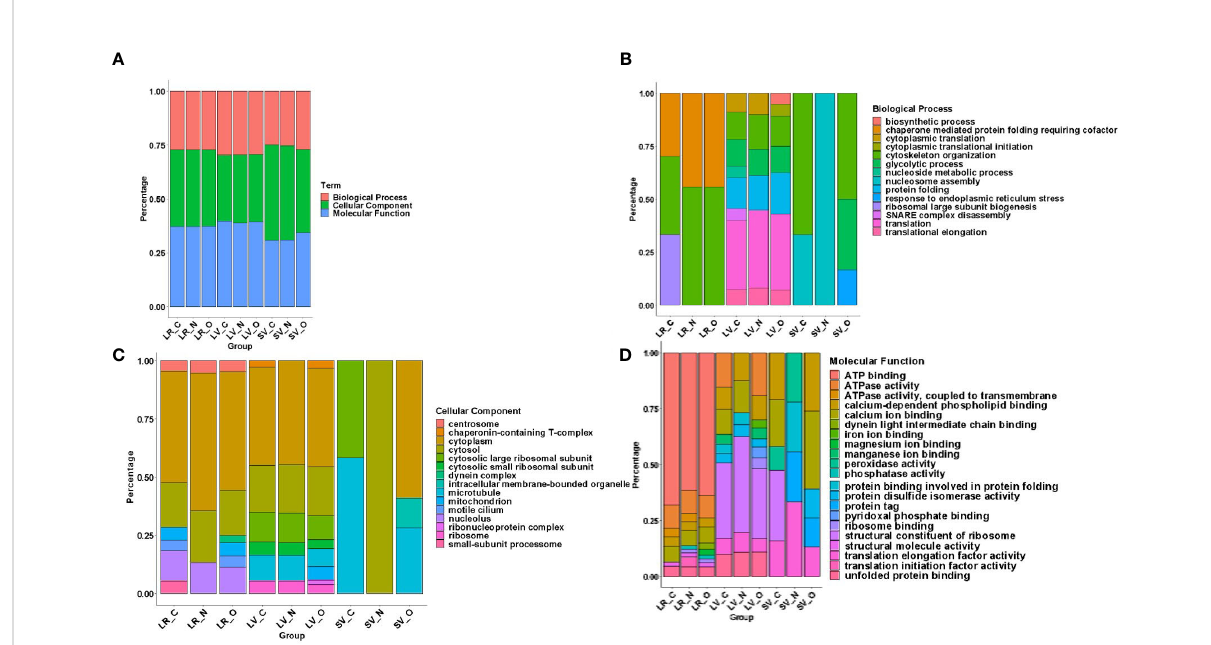
FIGURE 8 Protein Enrichment using DAVID was executed on RAW data across all groups including Lipid Raft: Control (LR_C), Nystatin (LR_N), Oseltamivir (LR_O), Large Vesicle: Control (LV_C), Nystatin (LV_N), Oseltamivir (LV_O) and Small Vesicle: Control (SV_C), Nystatin (SV_N), Oseltamivir (SV_O) as seen in panel (A) This was to determine their (B) Biological Process (C) Cellular Component and (D) Molecular Functions. Charts are normalized to a 100% for a more indicative representation of changes in process, component or function across fractions and